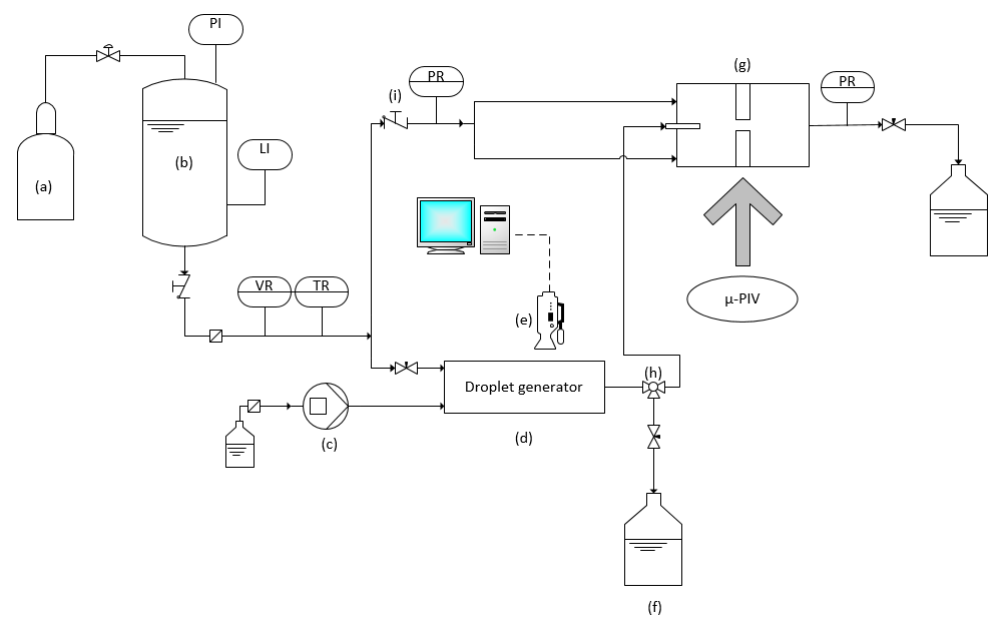
Figure 2. Experimental setup with pressurized gas cylinder ( a ), pressure vessel ( b ), displacement pump ( c ), droplet generator ( d ), camera with back lighting ( e ), collecting vessel ( f ), optically accessible orifice with positioning capillary ( g ), three-way valve ( h ) and shut-off valve ( i ).